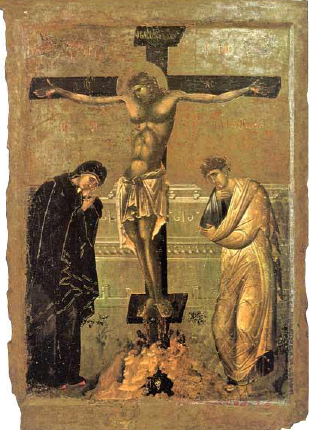
Fig. 10 The crucifixion, (14 th century), at Ohrid